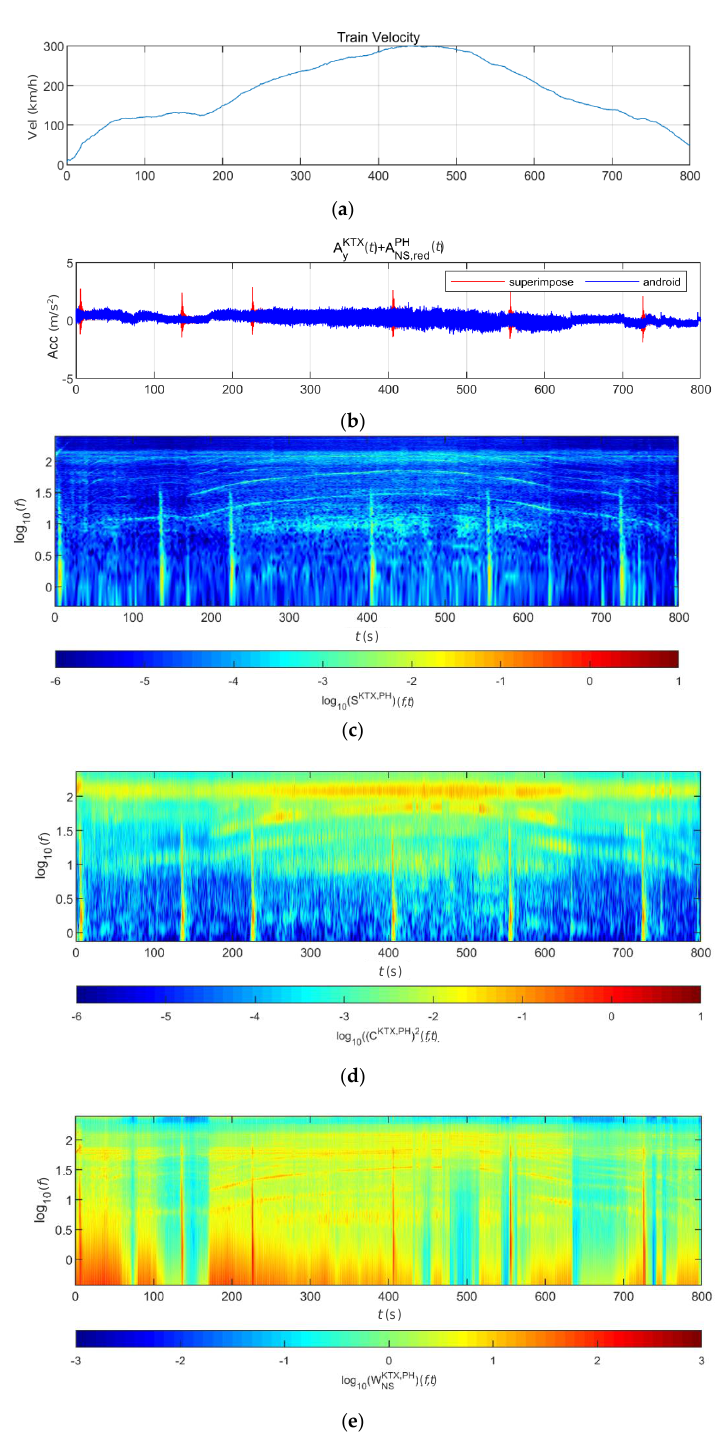
Figure 25. Combination of train data with the Pohang earthquake data (scaled to 2400-year return period): ( a ) velocity; ( b ) lateral acceleration time series; ( c ) STFT; ( d ) WT; ( e ) WVD.